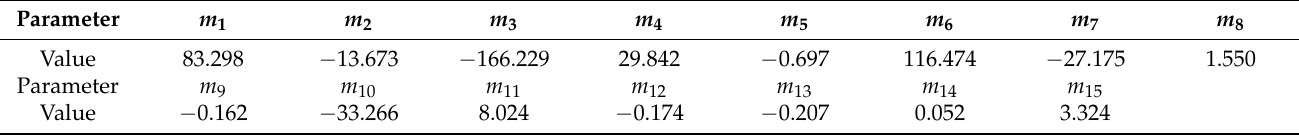
Table 8. Fitting results of the damping coefficient a 2 .